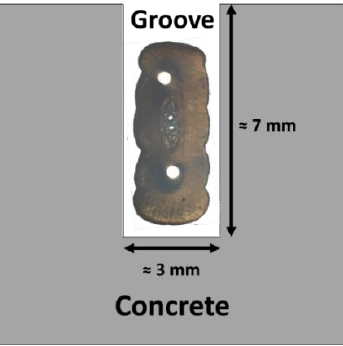
Figure 12. Positioning of the DOFS cable into the groove.